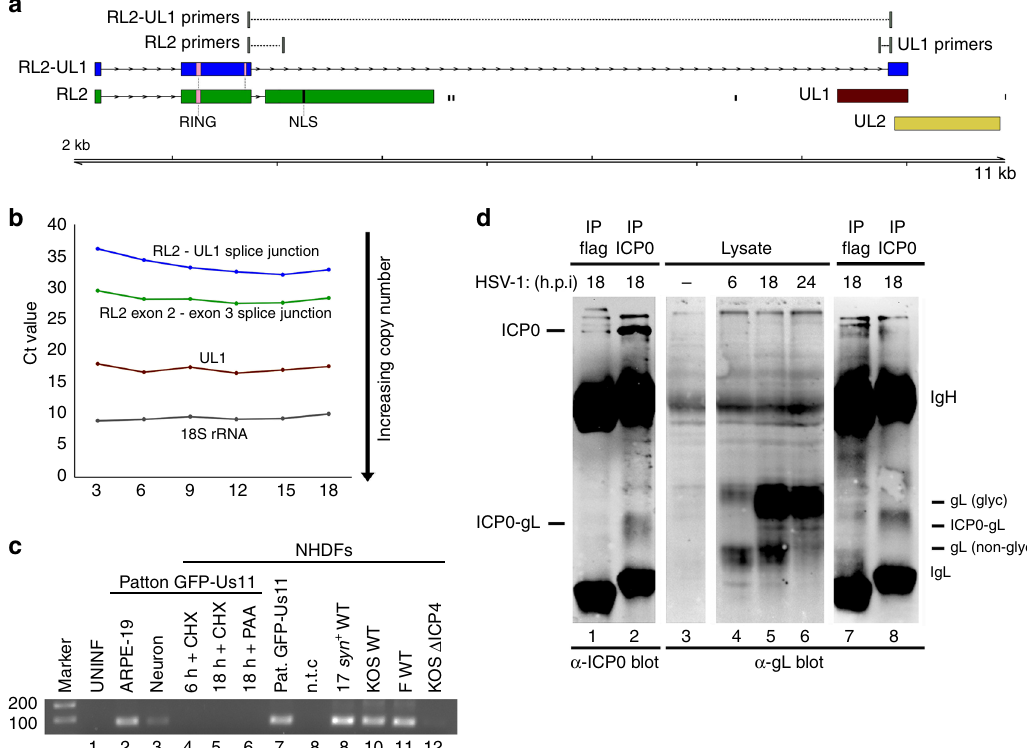
Fig. 7 Chimeric RL2 – UL1 mRNA is expressed with late kinetics and by multiple HSV-1 strains. a The RL2 – UL1 fusion transcript encodes an ICP0-gL fusion protein that lacks two phosphorylation sites (P2, P3) and the nuclear localization signal (NLS) domain present in ICP0. b Assessment of canonical RL2 exon2 – exon3 and novel RL2 exon 2 — UL1 internal splice junction usage at different times after infection by real-time RT-qPCR. Increased RNA abundance is re fl ected as lower crossover threshold (Ct) values and normalized to 18S rRNA. Three technical replicates were utilized per condition/time point. Representative data are shown from one of three biological replicates. c Detection of the unique RL2 exon 2 — UL1 splice by RT-PCR using a primer scanning the splice junction. NHDFs were infected in parallel with either HSV-1 strain Patton (lanes 2 – 7) or with wild-type strain 17 syn + (lane 9), KOS (lane 10), strain F (lane 11) viruses, or with n12, a KOS ICP4 null mutant (lane 12), and RNA was collected at either 6 h (lane 4) or 18 h (lanes 2 – 3, 5 – 7, and 8 – 12) post infection. Inhibitors of protein synthesis (cycloheximide, CHX) or the viral DNA polymerase (phosphonoacetic acid, PAA) were included as indicated (lanes 4 – 6). Ampli fi cation products were visualized with ethidium bromide. d Detection of the predicted ICP0-gL fusion protein. Lysates were prepared